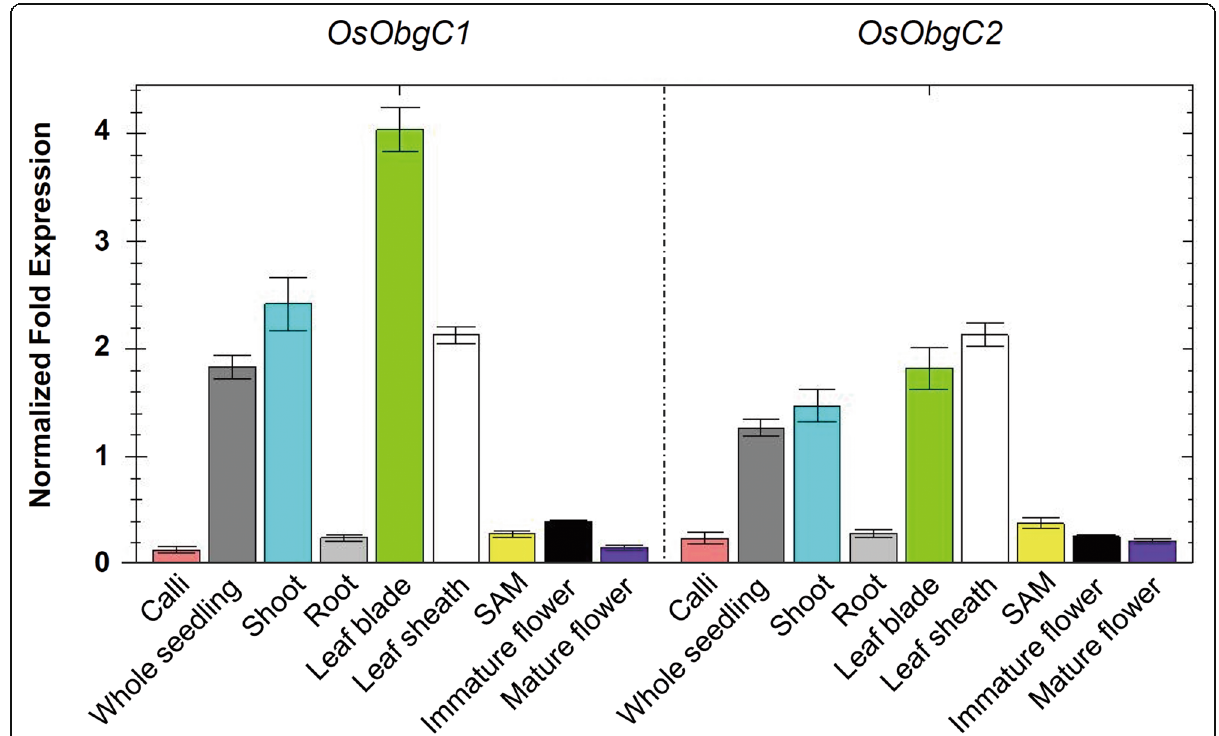
Fig. 2 Expression patterns of OsObgC1 and OsObgC2 in various tissues. Total RNAs were purified from the following tissues: calli, 10-day-old whole seedlings, shoots, roots, shoot apical meristem (SAM), leaf sheaths, leaf blades, and flowers from rice at reproductive stage. Transcript levels of OsObgC1 and OsObgC2 were determined using qRT-PCR with gene-specific primers. Each transcript level was normalized with that of OsActin as internal control. Each bar represents the mean ± SD value calculated from three independent experiments